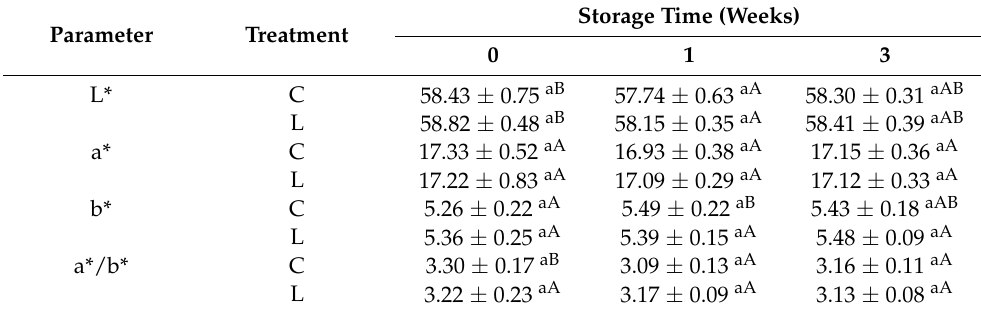
Table 4. Color parameters (mean ± SD) in the model sausages with MSPM during storage. Parameter